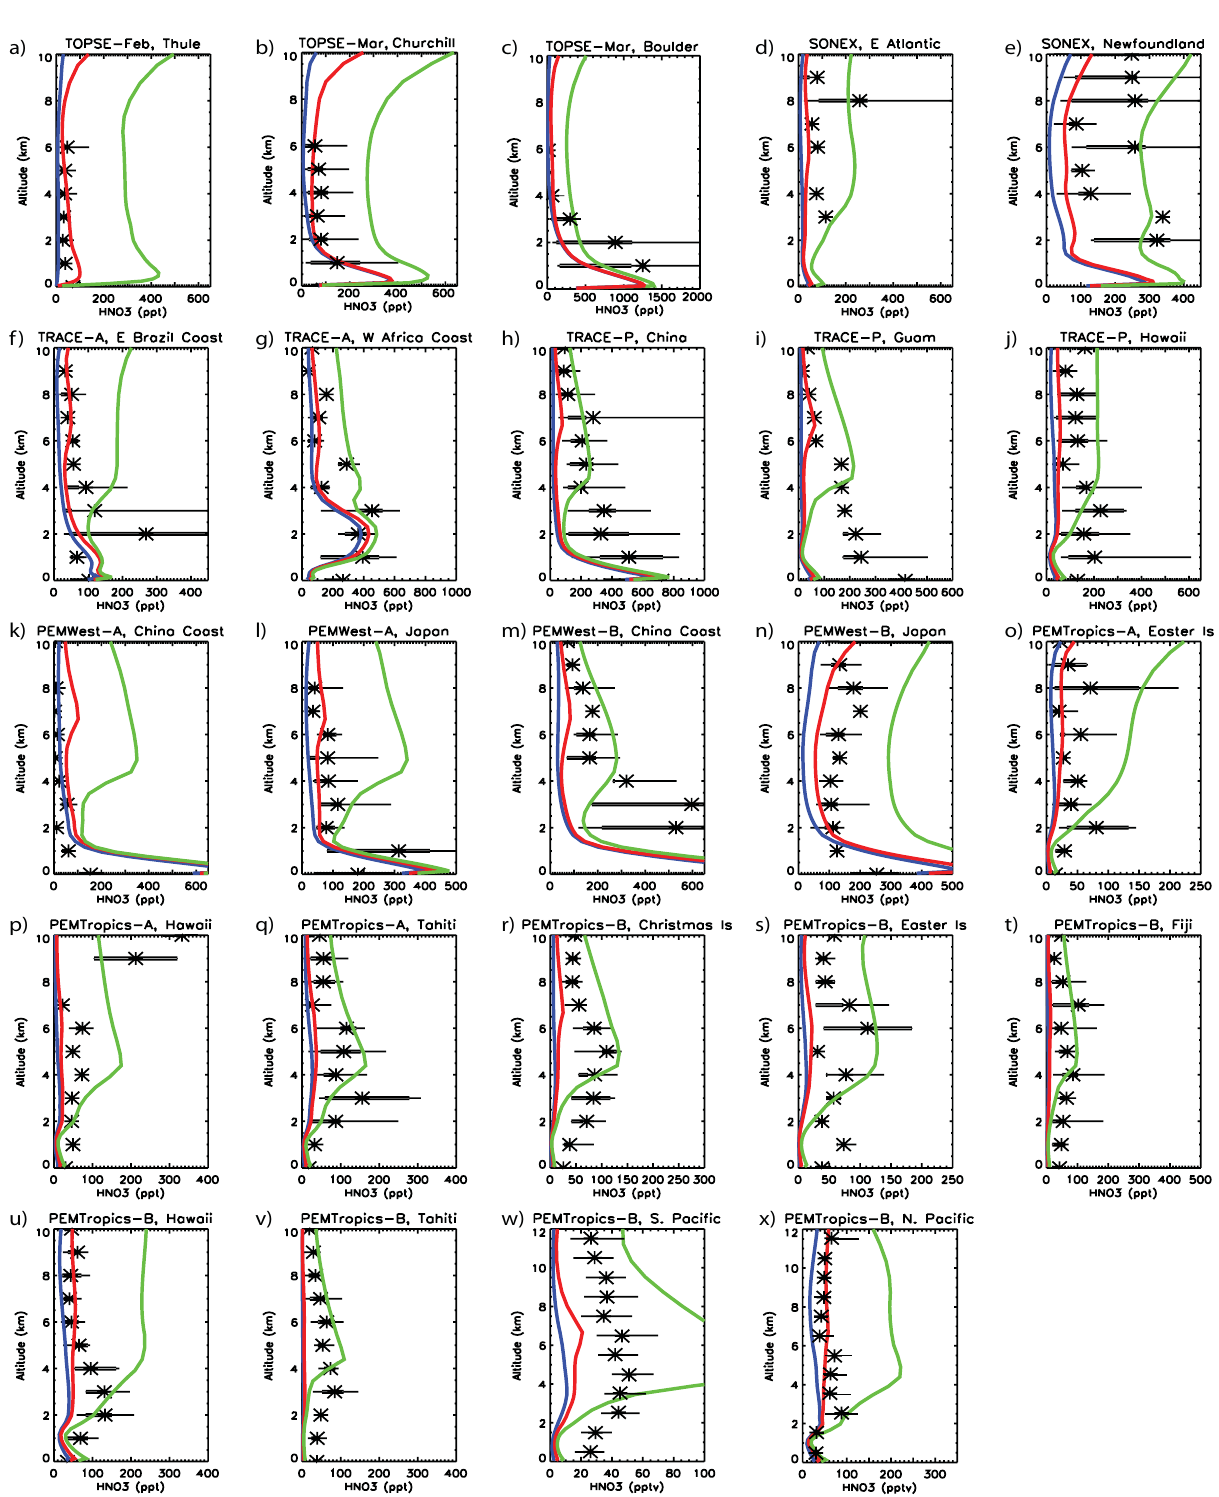
Fig. 2. (a–v) Comparison between UCI (red lines), UCI-NOICE (green lines), and GMI (blue lines) simulations and in situ HNO 3 measure- ments from aircraft campaigns (Emmons et al., 2000; http://www.acd.ucar.edu/gctm/data/). The aircraft measurements are aggregated over each campaign region at 5 ◦ × 5 ◦ × 1km resolution. Asterisks represent mean values, while boxes and whiskers represent the central 50% and 90% of the observations, respectively. (w)–(x) Same as (a–v) but data is aggregated over all S. Pacific and N. Pacific PEM-Tropics B flights (Staudt et al., 2003), and horizontal lines indicate minimum and maximum values of HNO 3 observed over each